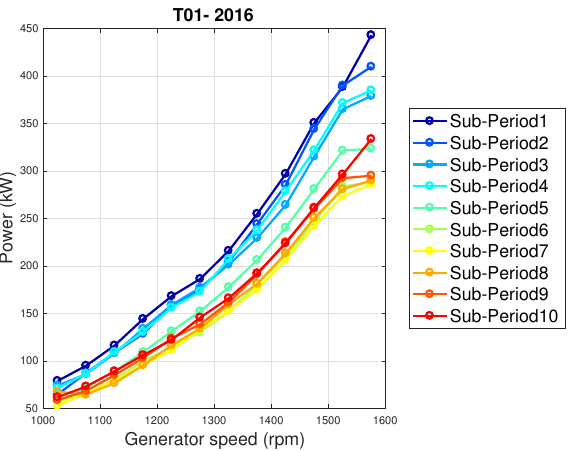
Figure 18. The generator speed–power curve in Region 2 for the T01 wind turbine in WF2 during 2016 (left): data have been divided into 10 sub-periods.